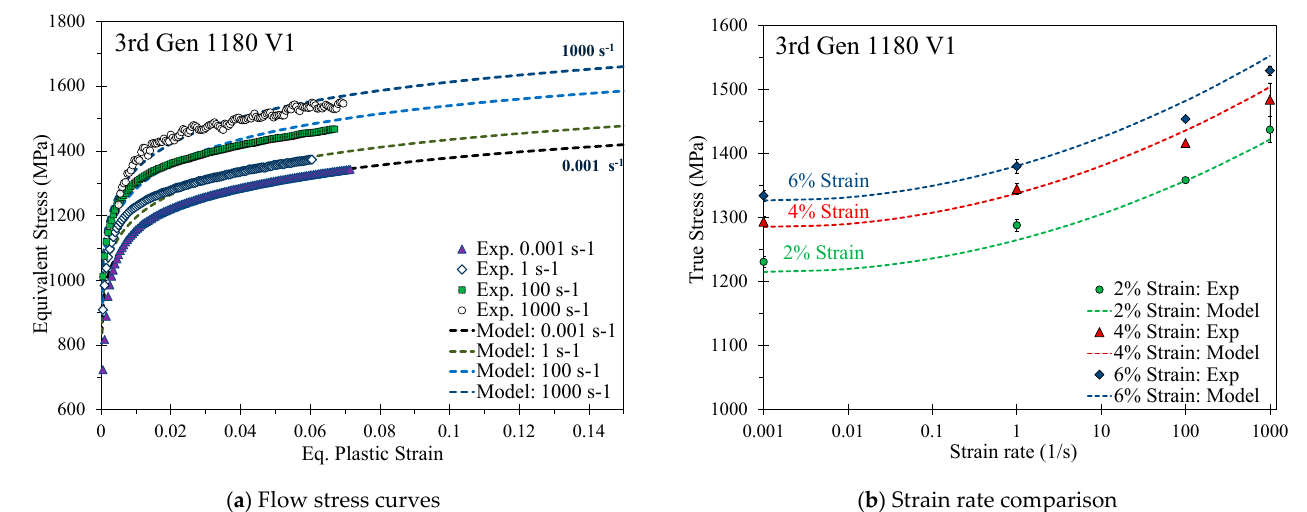
( a ) Flow stress curves ( b ) Strain rate comparison